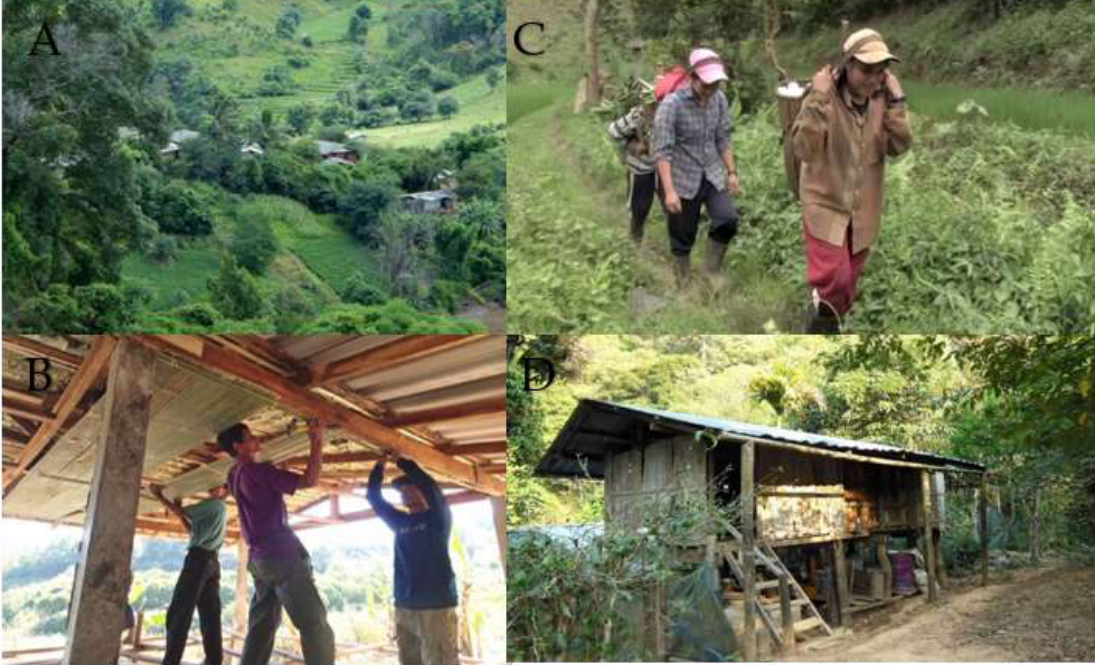
Figure 2. Lives of indigenous people at Ban Huai Hin Lat Nai in Chaing rai. ( A ) Houses are protected by tropical rainforest. ( B ) Houses being built by villagers. ( C ) Self-sufficiency and cultivation while protecting the forest. ( D ) Stilt food storage. (Photos are courtesy of Mr. Kunio Miyairi and Prof. Tatsuhiko Kawashima, GONGOVA, 2018).